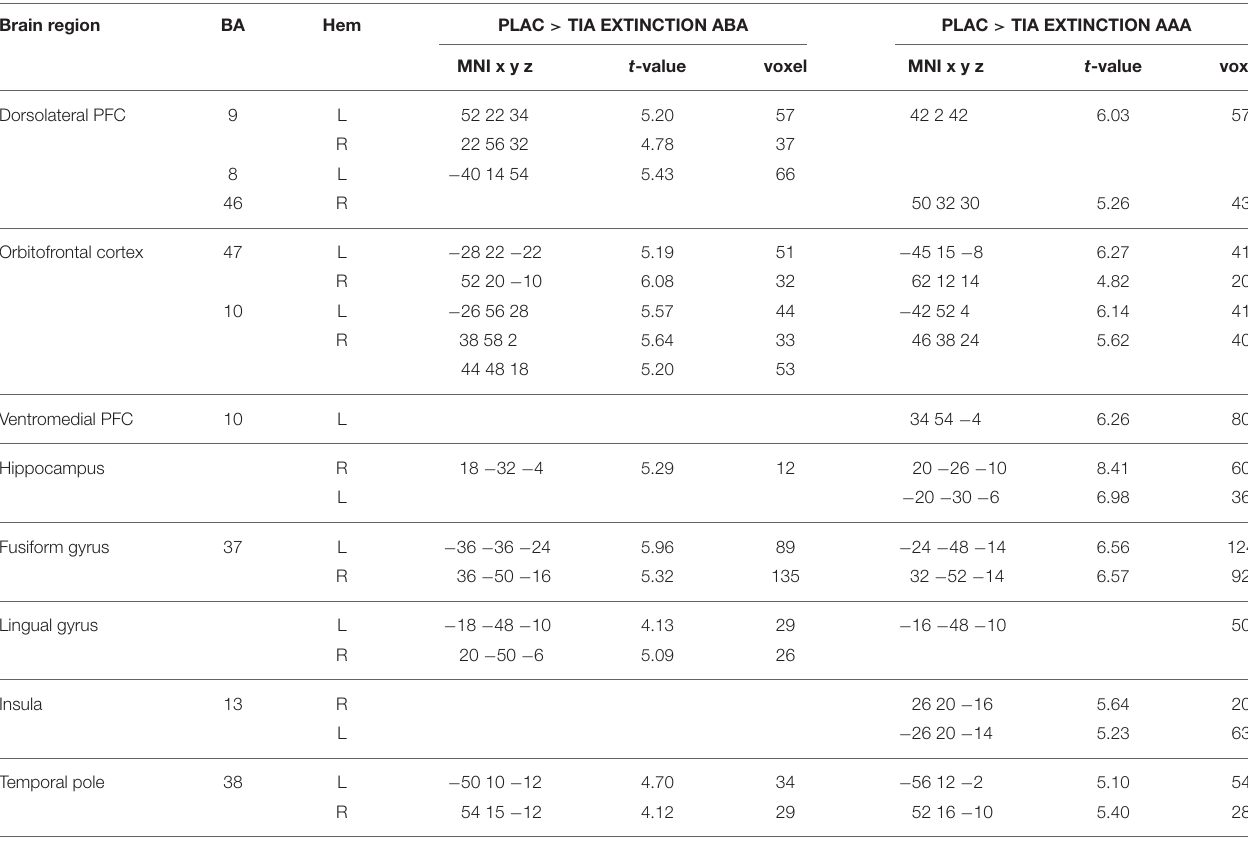
TABLE 3 | Two-sample test showing regions with higher activation in PLAC compared to TIA during extinction learning, p < 0 . 05 FWE-corrected, k = 10 . Brain region BA Hem PLAC > TIA EXTINCTION ABA Dorsolateral PFC